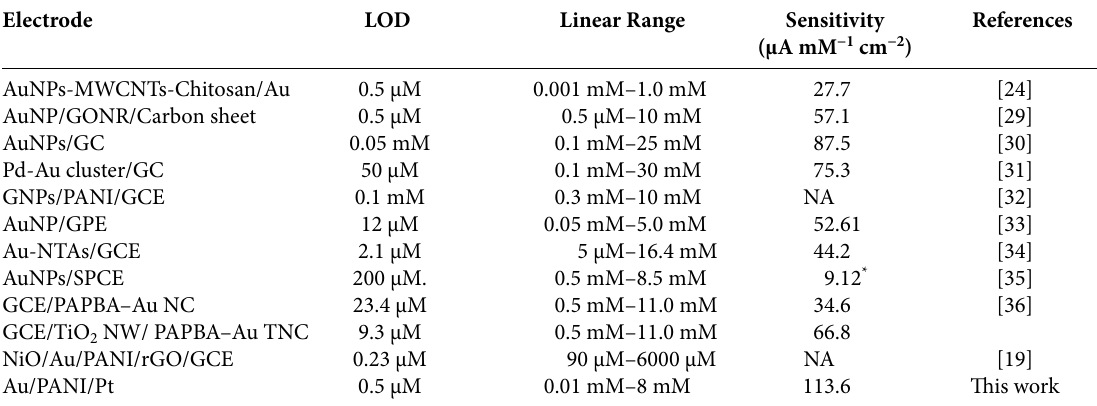
Table 1. Comparison of performance parameters of Au/PANI/Pt sensor to recently reported non-enzymatic glucose sensors based on Au particles Electrode